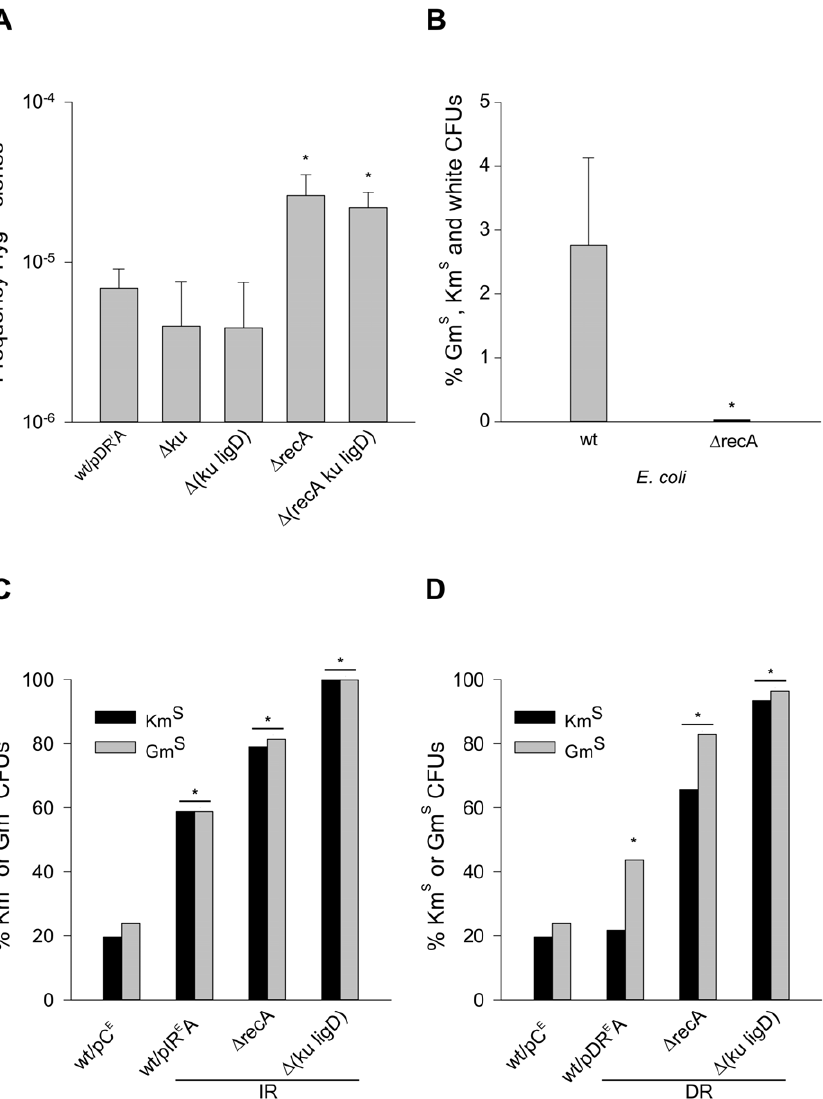
Figure 4. Deletions occur independently of NHEJ and HR in M.smegmatis . Panel A , precise deletions stimulated by DRs occur independently of NHEJ and are increased in the absence of RecA. x-axis , M. smegmatis strains: wt/pDR I A , wild-type/pMV306KmHyg::Oligo DR Gm A lacZ ; D ku , D ku/pDR I A; D (ku ligD) , D ku D ligD/pDR I A; D recA , D recA/pDR I A; D (recA ku ligD) , D recA D ku D ligD/pDR I A; y-axis , frequencies of Hyg R CFUs; asterisks, p , 0.05 (pair-wise Holm-Sidak test for mutant strains against wild-type). Panel B , large deletions are stimulated by HR (RecA) in E. coli . x-axis , E. coli strains carrying the self-replicating Oligo IR vector pIR E A; wt , KMBL1001; D recA , Top10 mutant; asterisks, p , 0.05 ( x 2 test of mutant strains against wild-type). Panels C and D , large deletions occur independently of NHEJ and HR in M. smegmatis . x axis , M. smegmatis strains; y-axis , percent Km S ( black bars ) or Gm S ( grey bars ) CFUs. Panel C , M. smegmatis strains: wt/pC E , wild-type/pMV206KmHyg::Gm (control); wt/pIR E A , wild-type/pMV206KmHyg::Oligo IR Gm A lacZ ; D (ku ligD) , D ku D ligD/pIR E A; D recA , D recA/pIR E A. Panel D , M. smegmatis strains: wt/pC E , as in Panel D; wt/pDR E A , wild-type/pMV306KmHyg::Oligo DR Gm A lacZ ; D (ku ligD) , D ku D ligD/pDR E A; D recA , D recA/pDR E A (asterisks, p , 0.05 ( x 2 test of mutant strains against wild-type).